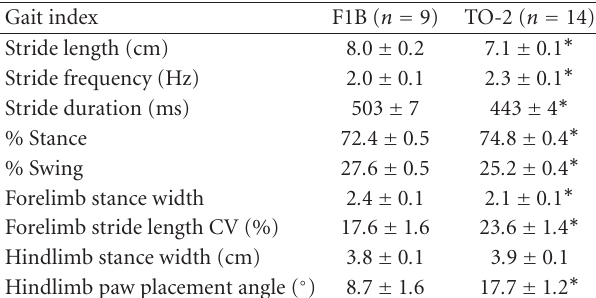
Table 1: Gait dynamics in 9-month-old F1B control hamsters and delta-sarcoglycan-deficient TO-2 dystrophic hamsters walking on a treadmill belt at a speed of 16 cm/s.